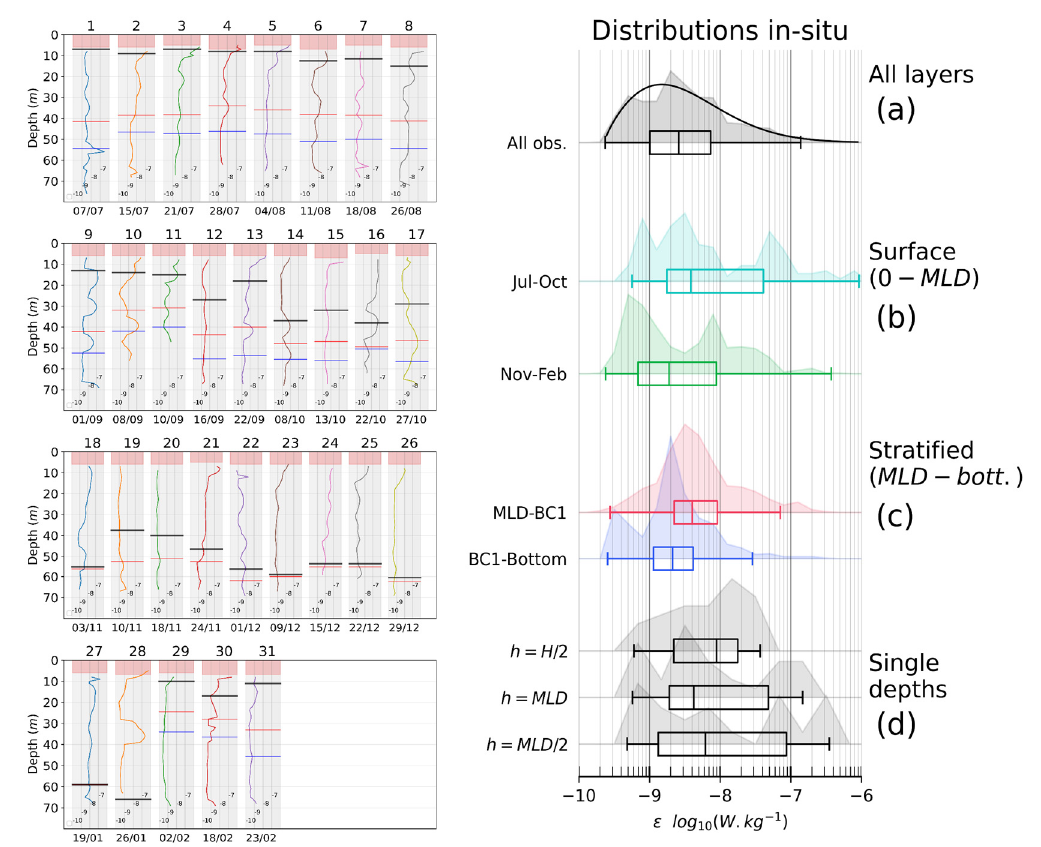
Figure 5. ( left ) Vertical profiles of 𝜀 (𝑊. 𝑘𝑔 (cid:2879)(cid:2869) ) 𝑖𝑛 𝑙𝑜𝑔 10 , during the two periods July–October (JO), then November–February (NF). Red areas indicate the surface part that is removed from the statistics. Black lines: MLD . Red and blue lines: average depths of the two first baroclinic modes BC 1 and BC 2 , respectively. ( a – c ) Boxplots of ε (( a ): all values; ( b ): surface layers during the two periods JO and NF; ( c ): stratified layers, MLD − BC 1 and BC 1 − bottom ). Shapes of the associated PDFs are plotted in color (black line on ( a ): Burr type XII fit). ( d ) Boxplots of epsilon at single depths ( h = H /2, MLD , MLD